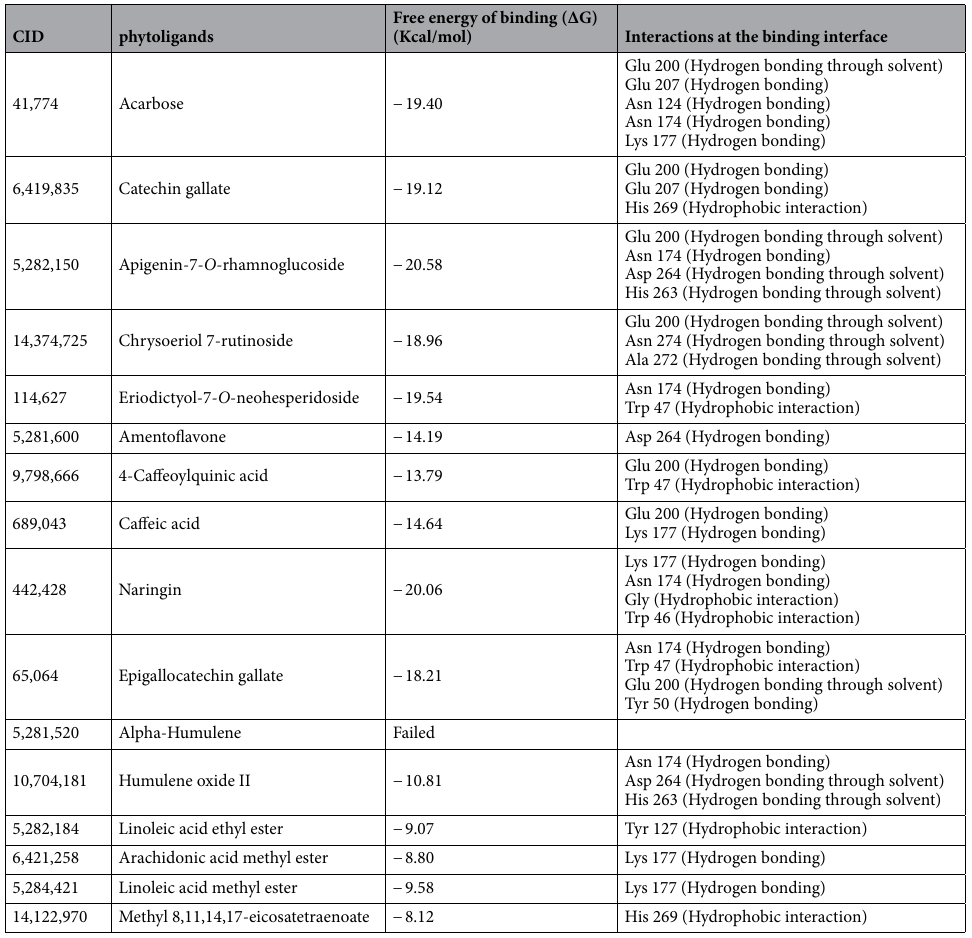
Table 4. Docking simulations results of the studied phytoligands identified by GC/MS and HPLC-MS/MS analysis, respectively using acarbose as a co-ligand. *The best ligand-receptor complex binding free energy at RMSD < 2